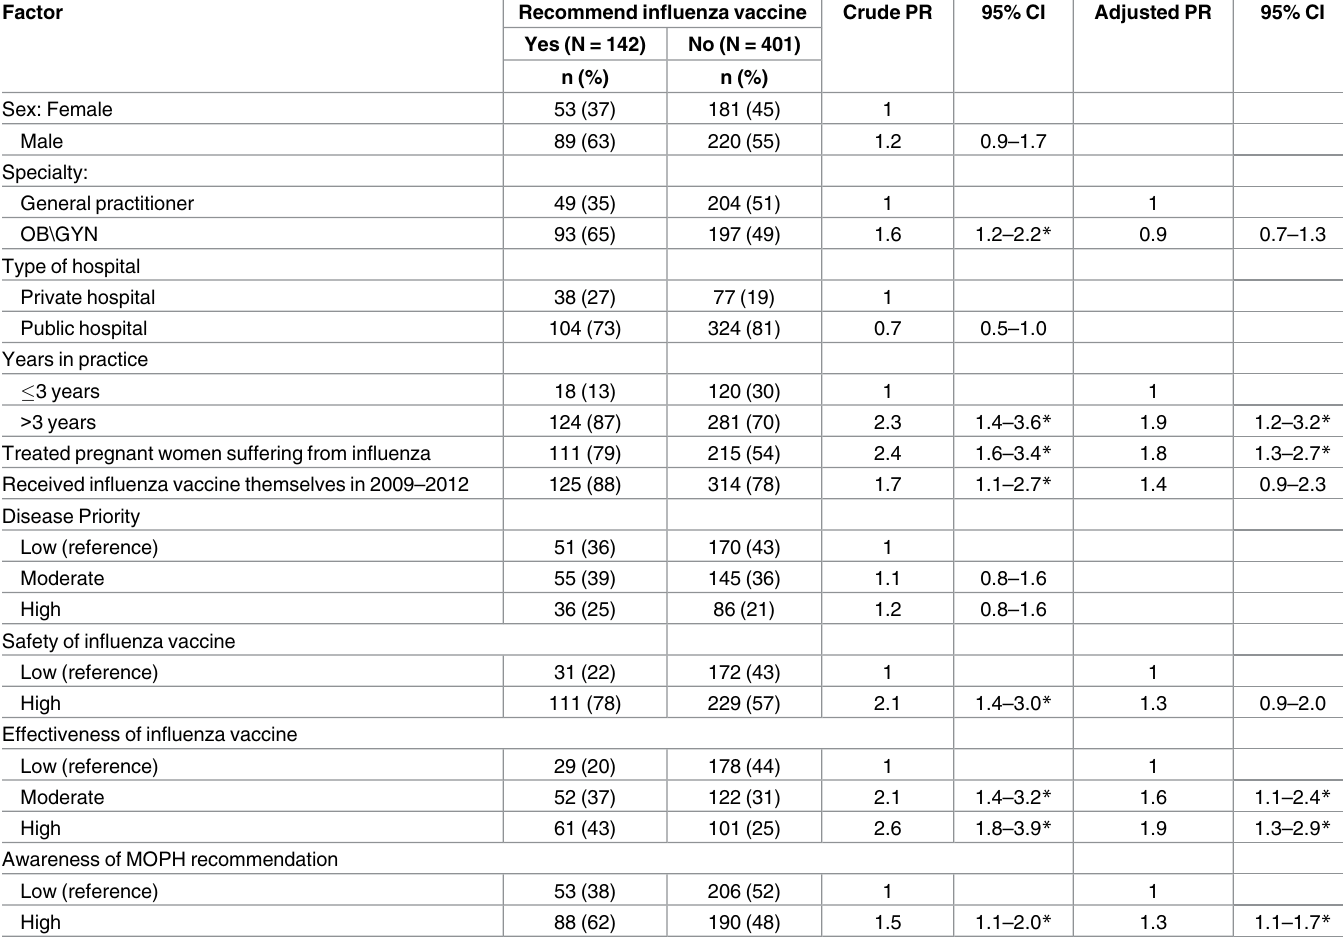
Table 4. Associated factors for vaccine recommendation among respondent physicians (N =